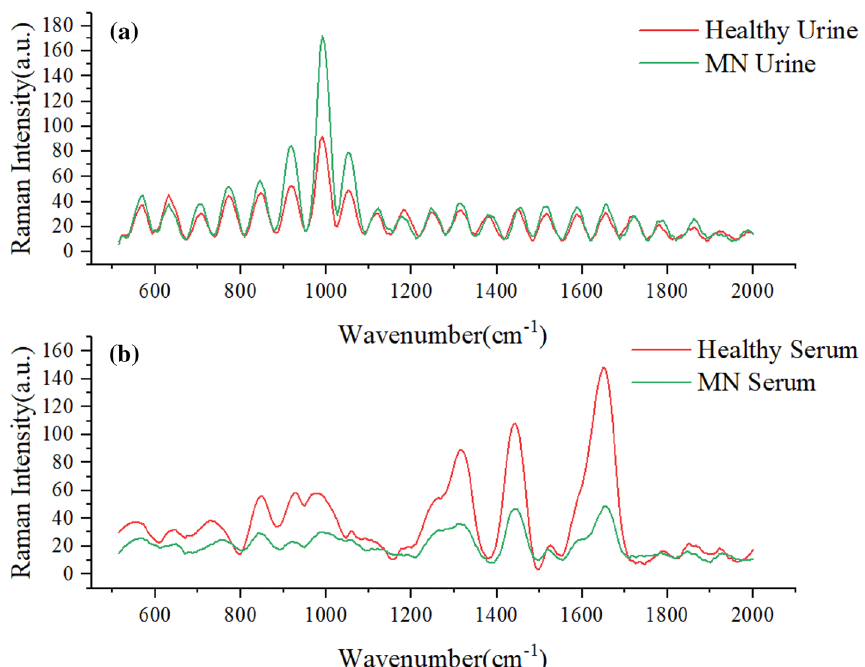
Figure 1. ( a ) Average spectra of urine and healthy samples from MN patients ( b ) Average spectra of serum and healthy samples from MN